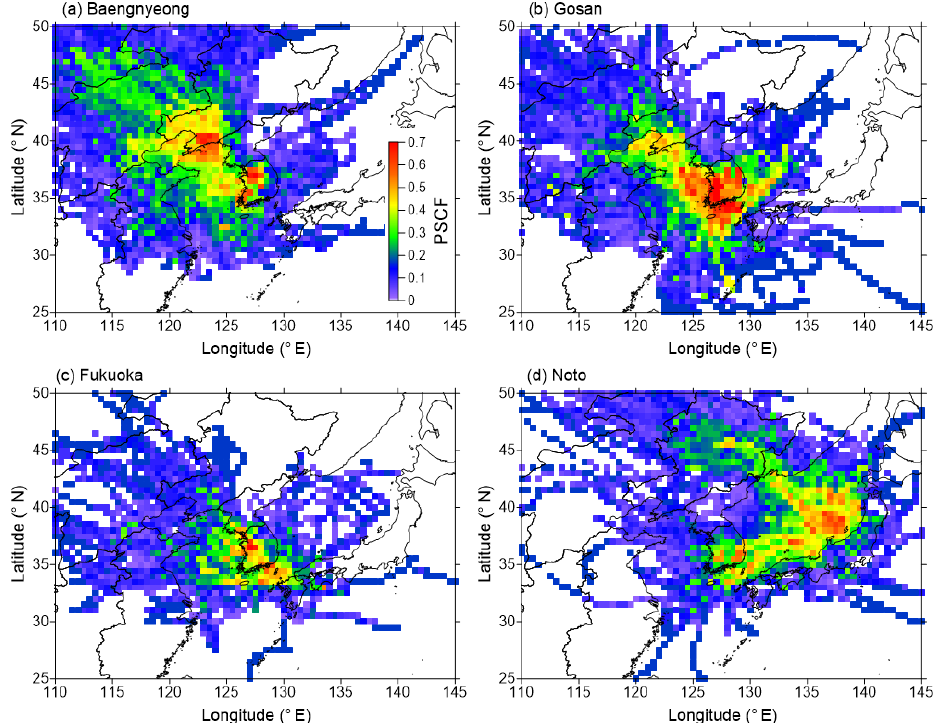
Figure 5. Spatial distribution of the PSCF results for the mean fractional bias (MFB) ≥ 0.5 for overestimation cases at the (a) Baengnyeong, (b) Gosan, (c) Fukuoka, and (d) Noto sites. MFB is calculated from 2 × ( R i − M i )/(R i + M i ) , where R i and M i denote the mean values of the recalculated REAS BC / CO ratio along with the backward trajectory and the measured BC / CO ratio,